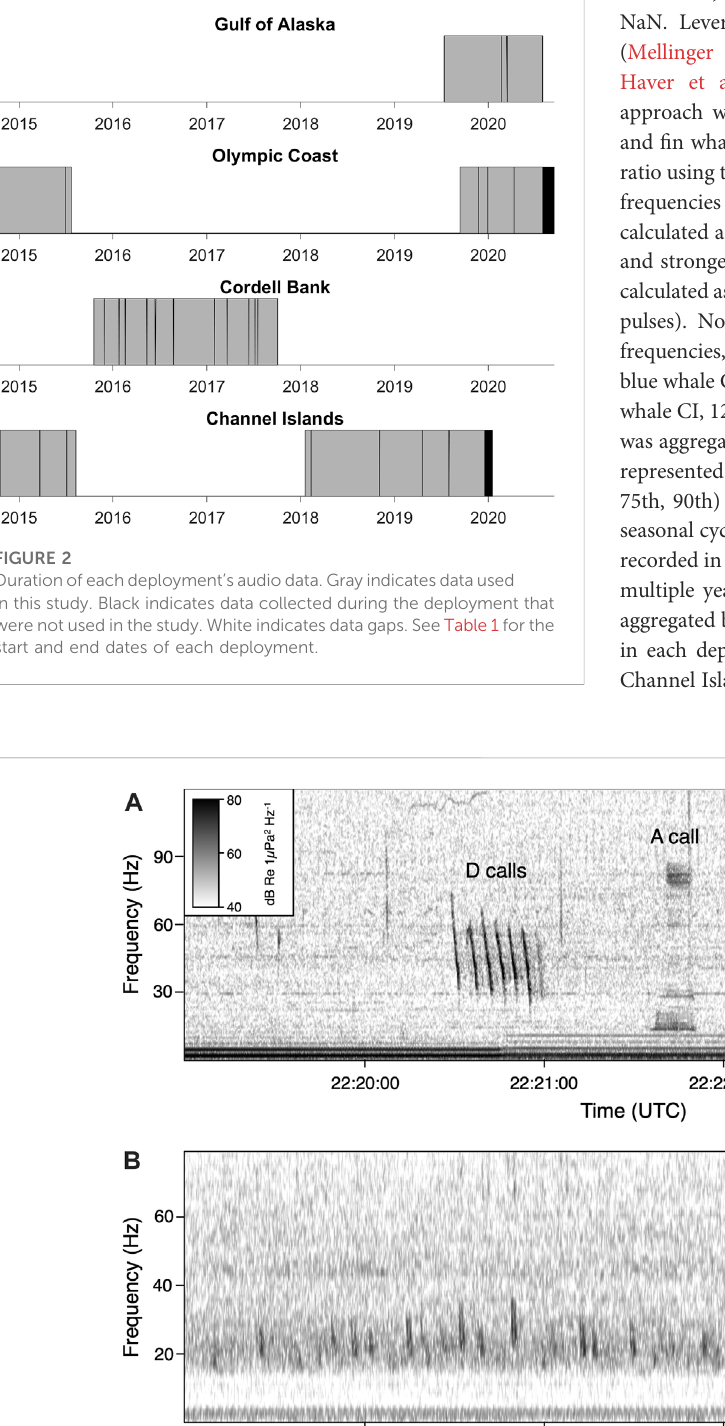
Frontiers in Remote